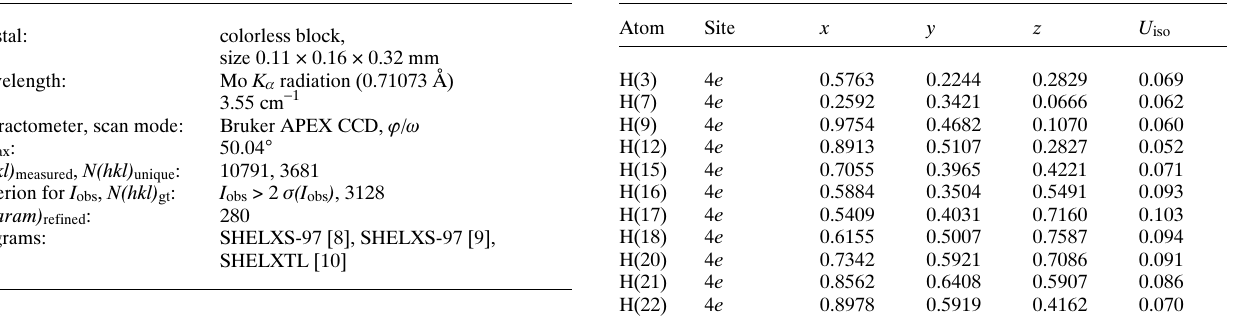
Table 2. Atomic coordinates and displacement parameters (in Å 2 ) . Table 1. Data collection and